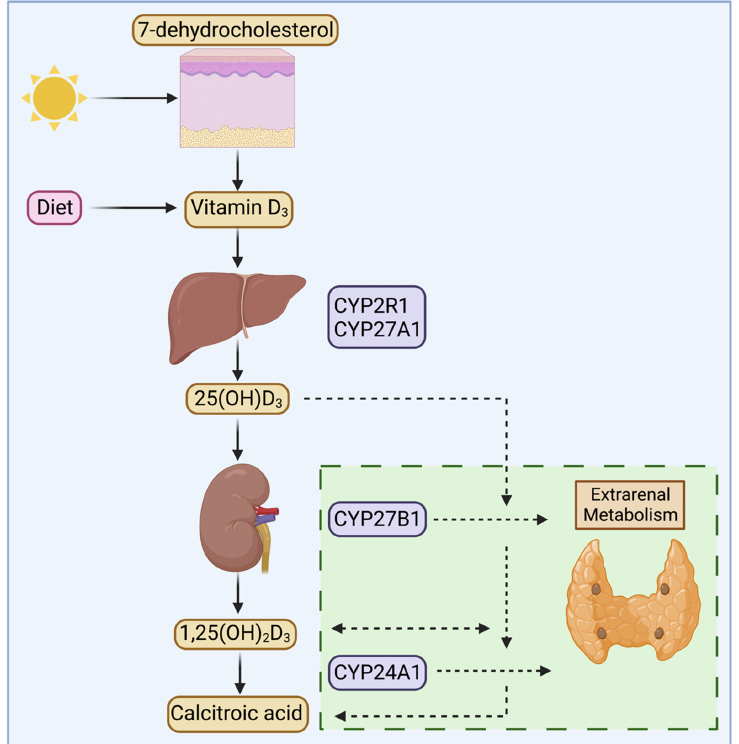
Figure 1. General overview of vitamin D metabolism. Vitamin D 3 can be obtained after ultraviolet- mediated conversion of 7-dehydrocholesterol or from dietary sources. It then undergoes hydroxylation at the 25-position primarily through the enzymes cytochrome P450 (CYP) 2R1 or CYP27A1 to generate 25 hydroxyvitamin D 3 (25(OH)D 3 ). Maintenance of circulating levels of 1,25 dihydroxyvitamin D 3 (1,25(OH) 2 D 3 ) is primarily achieved after CYP27B1-mediated 1 α -hydroxylation of 25(OH)D 3 in the kidney, and CYP24A1 promotes catabolism of vitamin D compounds. Recent evidence shows that CYP27B1 and CYP24A1 are expressed in extrarenal calciotropic tissues, such as the parathyroid gland, raising possibilities for local, tissue-specific vitamin D activation, action, and inactivation.